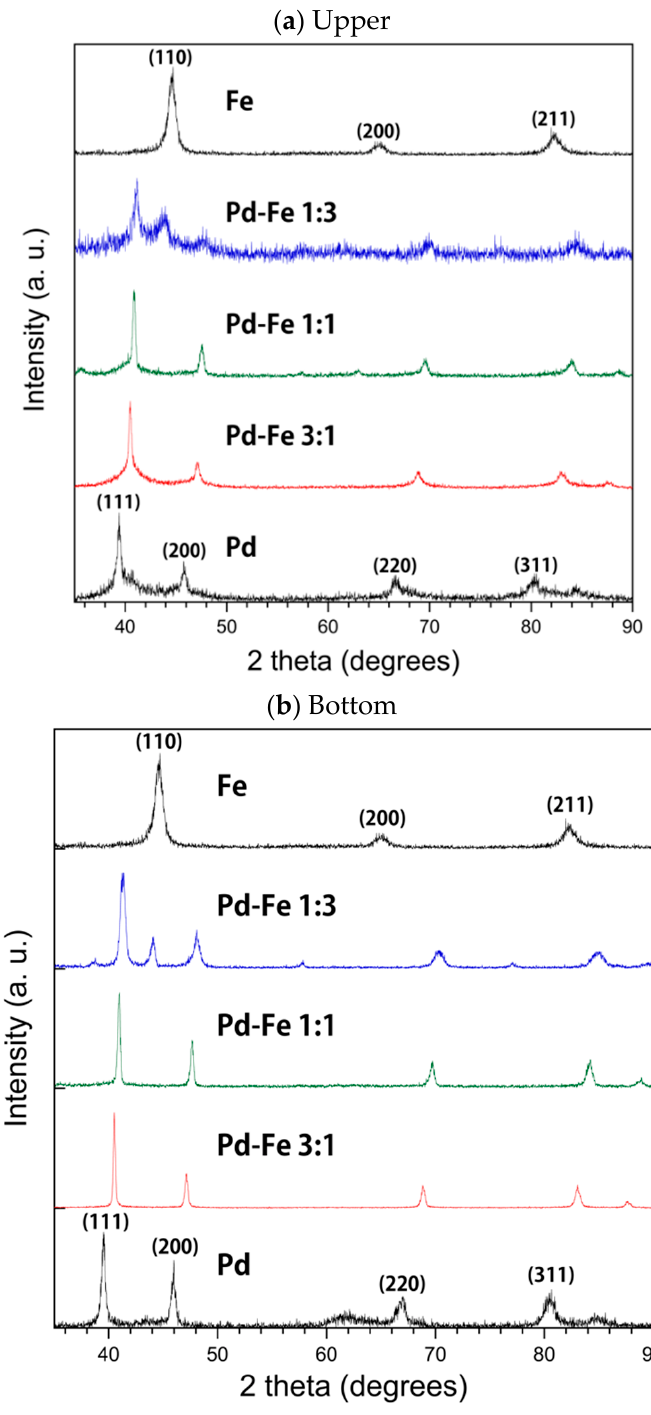
Figure 3. XRD patterns of Pd-Fe alloy nanoparticles and of elemental Pd and Fe nanoparticles in upper ( a ) and bottom ( b ) samples.